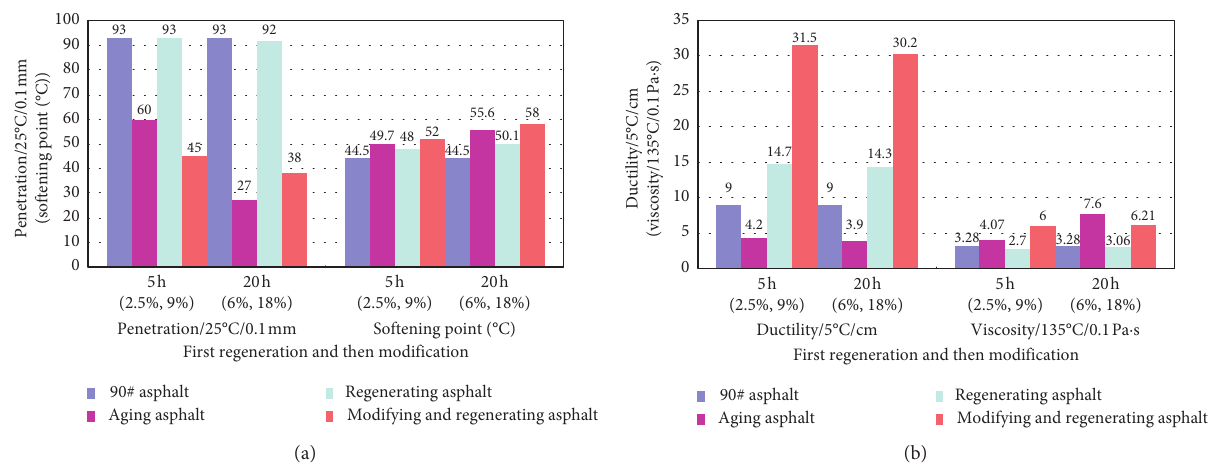
Figure 6: Index relationships of first regeneration and then modification of aging asphalt. Table 10: Indexes of first modification and then regeneration of aging